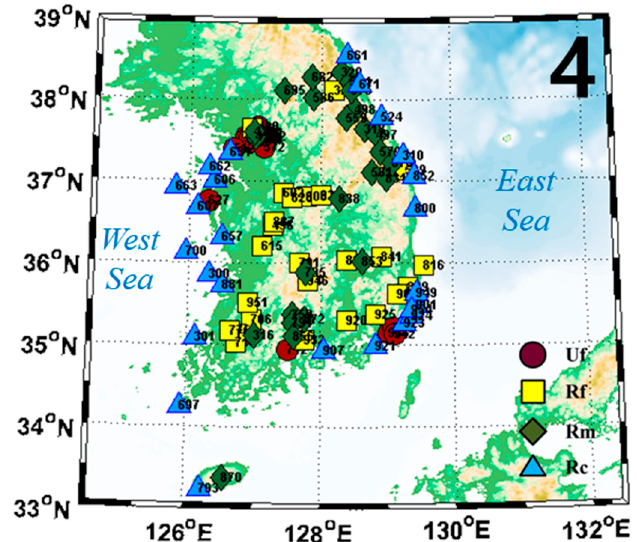
Figure 2. The locations of the AWSs in four categories selected in this study.